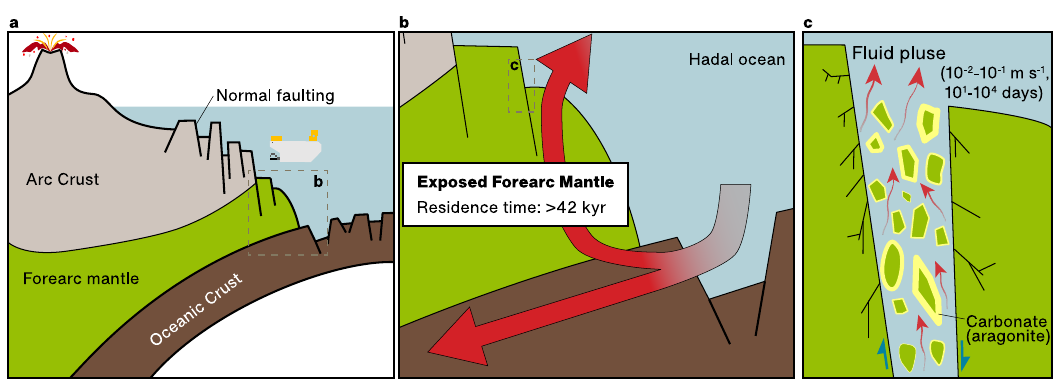
Fig. 4 Fluid dynamics in the tectonically exposed forearc mantle. a Schematic illustration of the erosive convergent margin in the IOT and DSV Shinkai 6500 . b Simpli fi ed illustration of the area represented by the dashed gray rectangle in a , showing fl uid circulation in the tectonically exposed forearc mantle. c Fluid fl ow and carbonation at fracture indicated by the dashed gray rectangle in b . Schematic illustration of the episodic rupture events that allow the accumulated seawater to discharge. Each event continues for 10 1 to 10 4 days with a velocity of 10 − 2 to 10 − 1 m s − 1 and induces